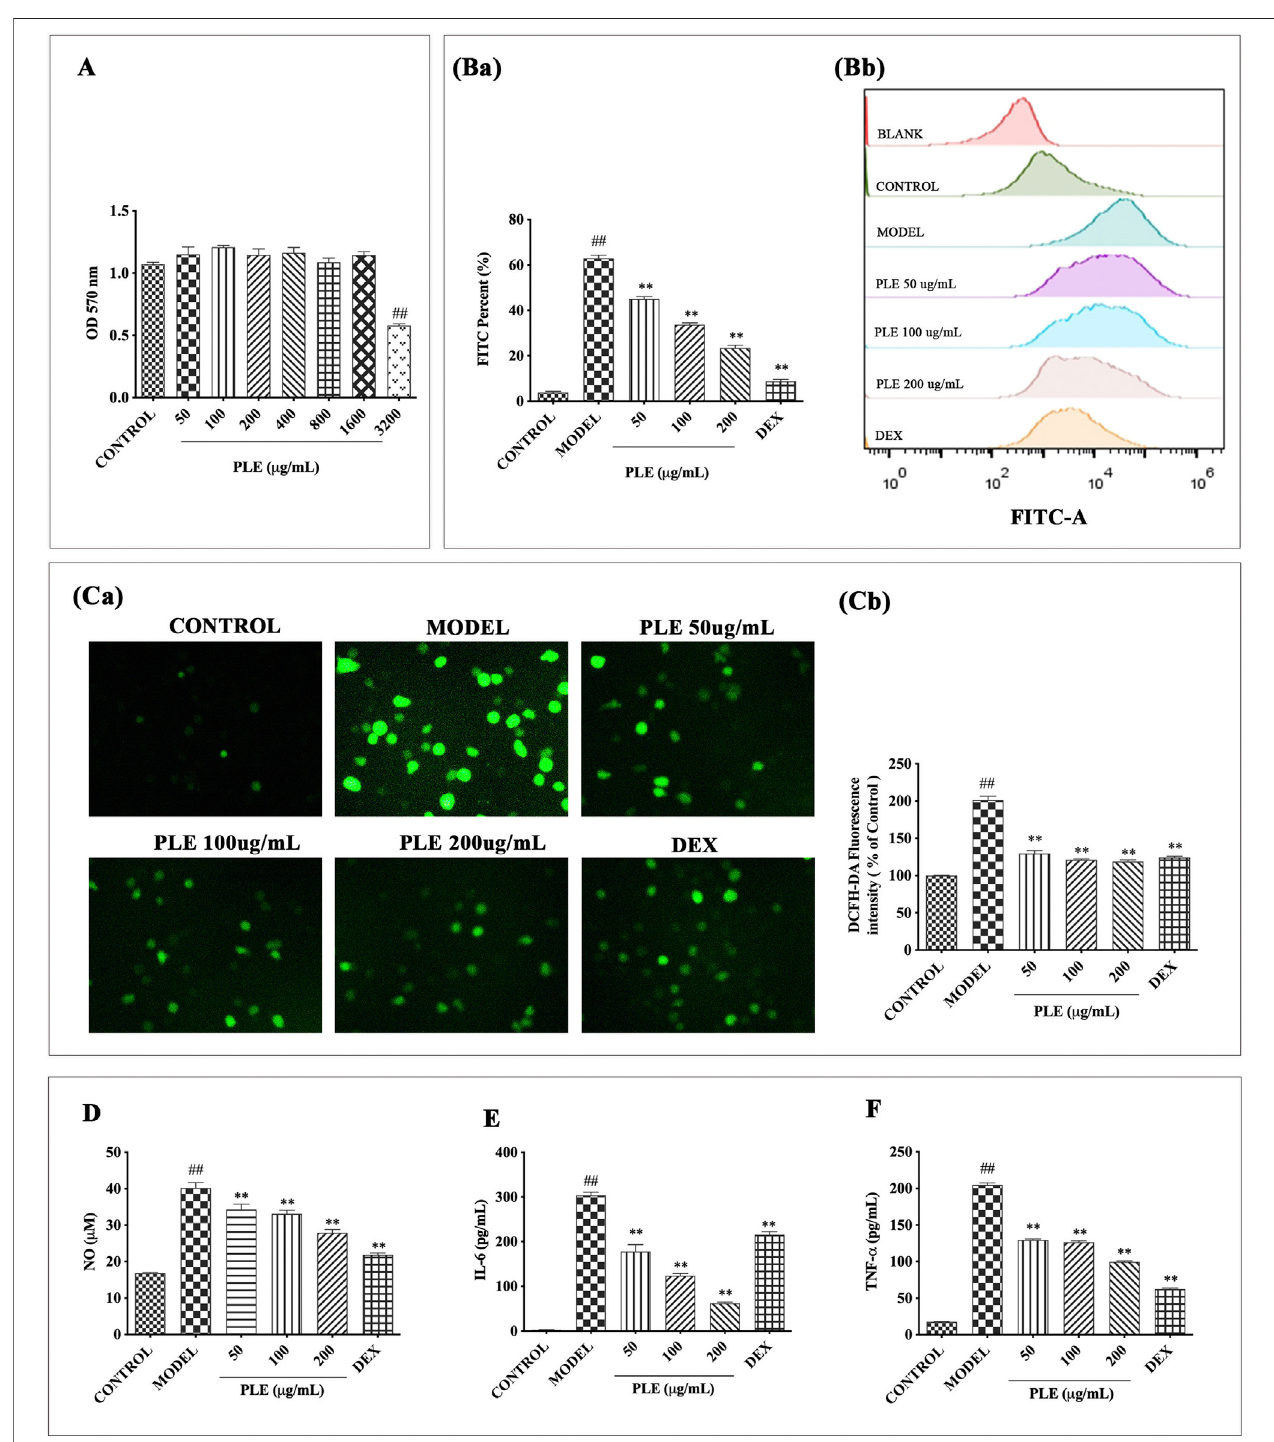
FIGURE 3 | Effects of the PLE on in fl ammatory responses in LPS-stimulated RAW264.7 macrophages. (A) Cell proliferation was measured by MTT assay. (Ba) Intracellular ROS was determined by fl ow cytometry and (Bb) its DCFH-DA fl uorescence shift was calculated by FlowJo software. (Ca) Representative images (magni fi cation × 200) of cells DCF fl uorescence visualized and (Cb) their intensity was analyzed by ImageJ software. Levels of NO (D) in cell culture supernatants were detectedbyGriessassay, and IL-6 (E) and TNF- α (F) weredetectedbyELISAassays.Experiments werecarried outon 3separate experiments. Datawereshown as mean ± SEM. # p < 0.05 and ## p < 0.01 compared with the CONTROL group; * p < 0.05 and ** p < 0.01 compared with the MODEL group.